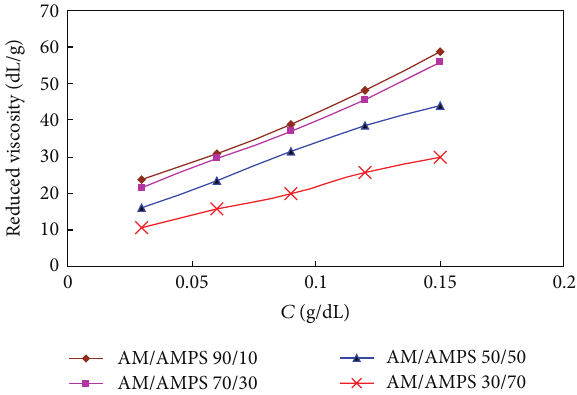
Figure 4: Variation of reduced viscosity of copolymer solution versus copolymer concentration in aqueous salt solution at 25 ∘ C.